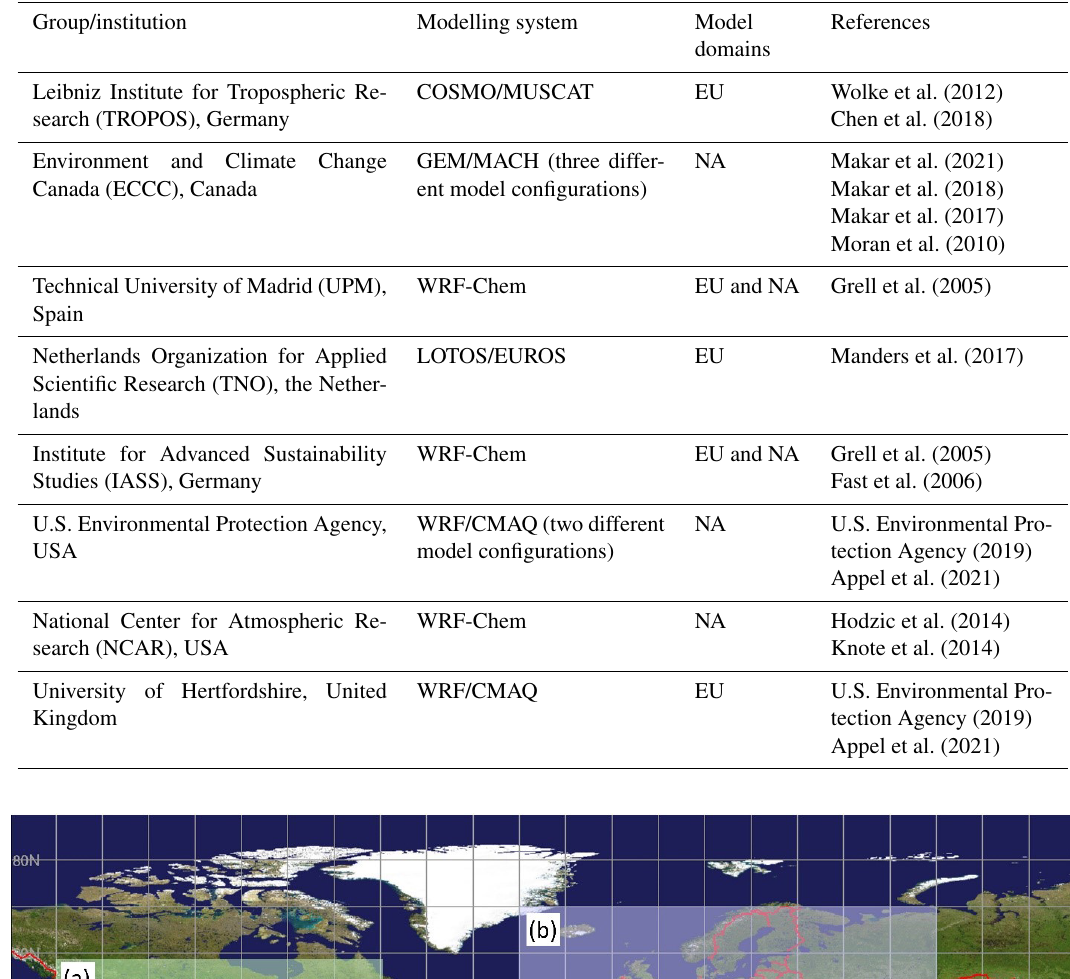
Table 1. Participating institutes, model names, and cases simulated.